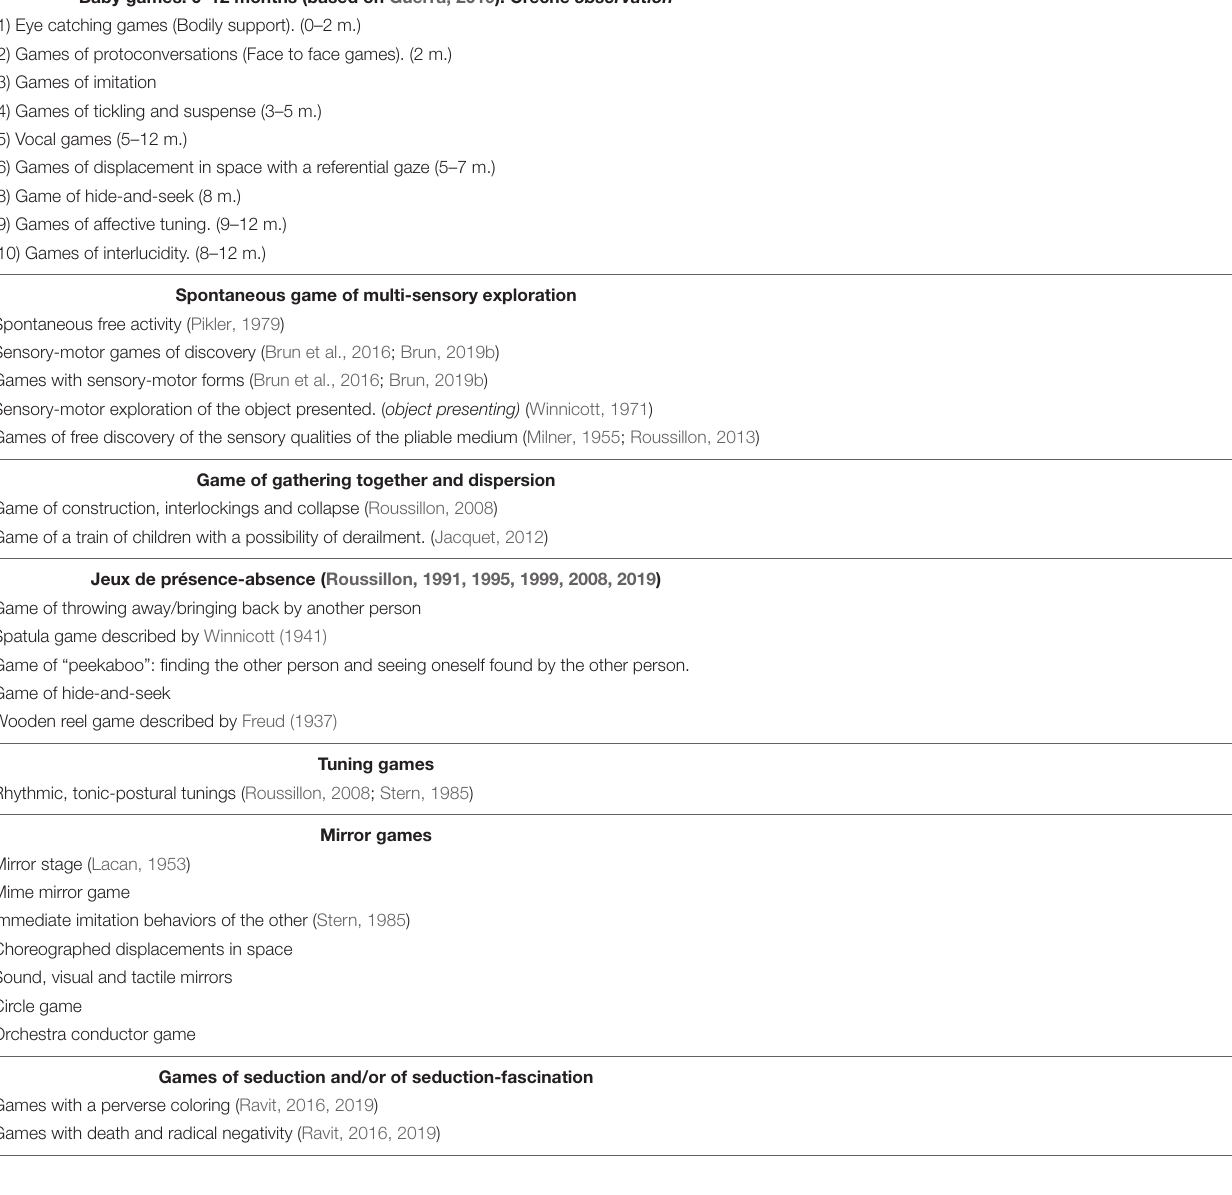
TABLE 2 | Typical games and therapeutic mediations Typical games. Baby games. 0–12 months (based on Guerra, 2019). Crèche